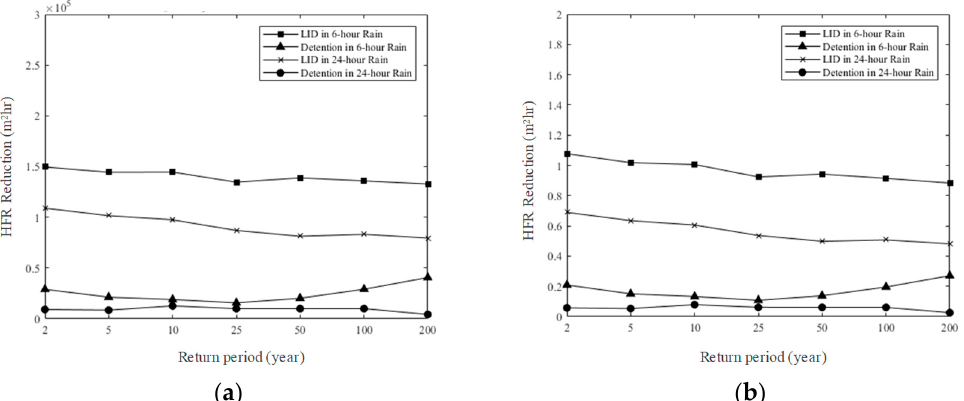
Figure 5. The HFR reduction by LIDs and detention ponds on different rainfall durations and return periods: (a) quantify of the HFR reduction; ( b ) percentage of the HFR reduction.